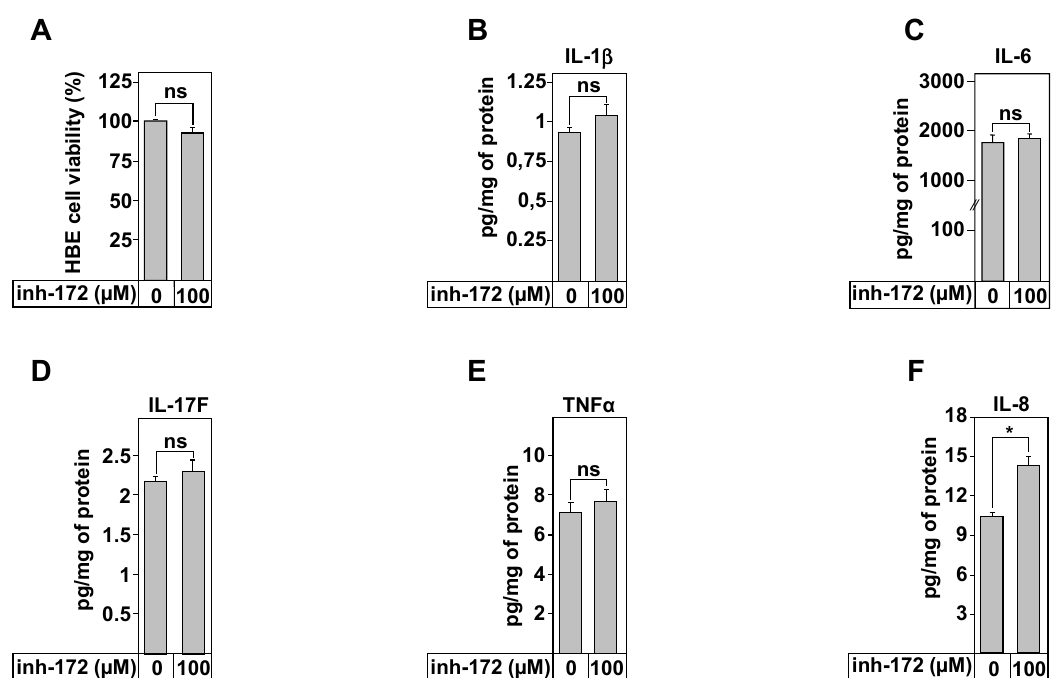
Figure 5. Effect of CFTR inhibition on cytokines secretion in HBE cells. ( A ) Evaluation of HBE viability using MTT assays following 24 h incubation with 100 µM of inh-172, a CFTR chloride channel inhibitor. ELISA tests were used to measure IL-1 β ( B ), IL-6 ( C ), IL-17F ( D ), TNF α ( E ), and IL-8 ( F ) secretion in the culture media of HBE cells treated during 24 h with 100 µM of inh-172. Values overwritten with stars are significantly different from the control ( p < 0.05). Data are expressed as mean ± SE ( n = 6).